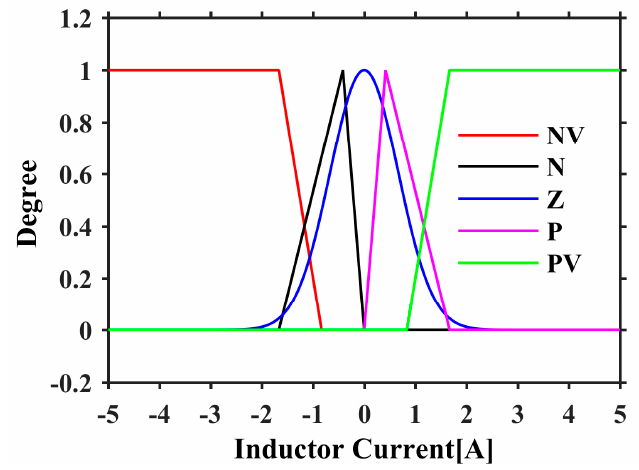
Figure 9. Membership function of inductor currents.